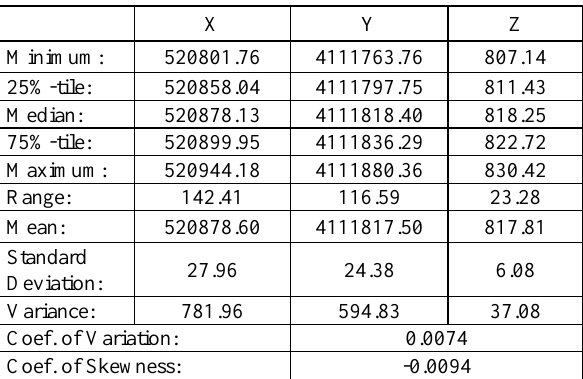
Figure 11. Perspective view of the 3D contours lines with 1 m interval